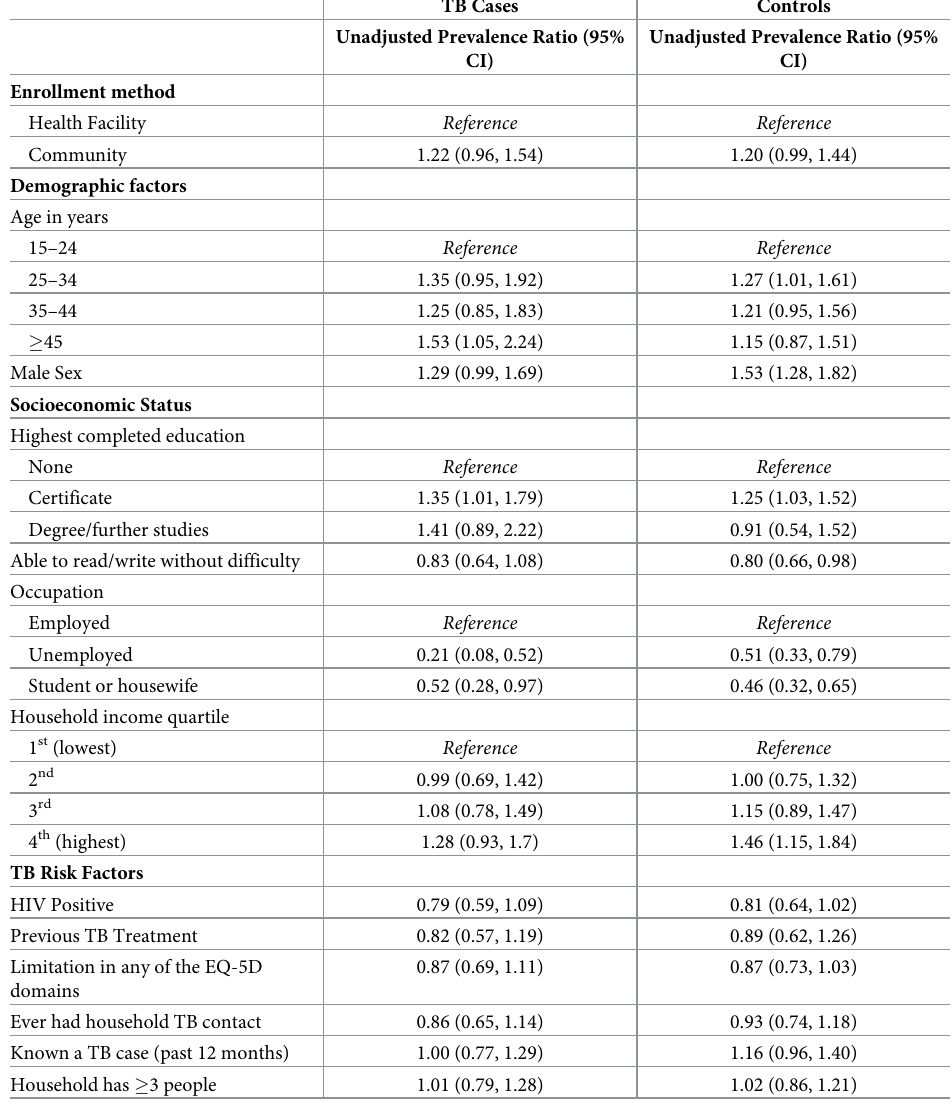
Table 3. Association of demographic, socioeconomic, and TB risk characteristics with mobility �